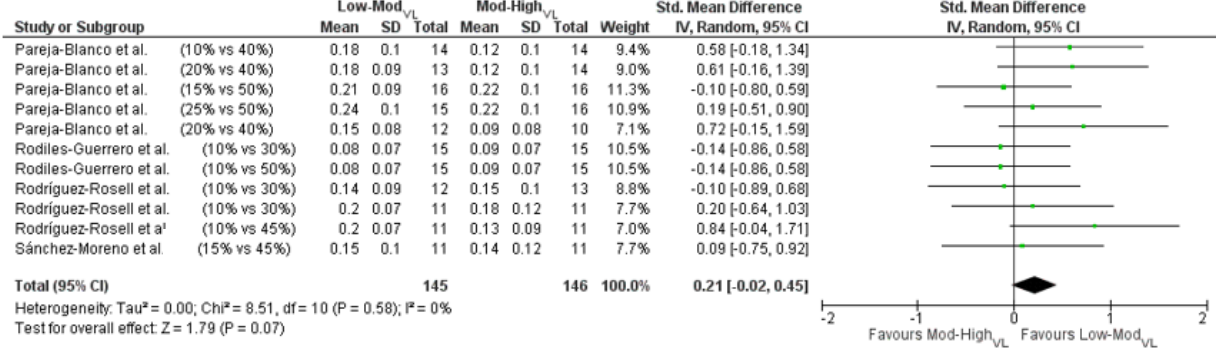
Figure 3. Between-group analysis comparing the effects of Low-Mod VL (≤25% intra-set VL) and Mod-High VL (>25% intra-set VL) to promote changes at moderate/high loads (absolute loads lifted slower than 1.00 m·s −1 and 0.80 m·s −1 at pre-training in the squat and bench press exercises, respectively, >60% 1RM [35,36]). Green squares: ES for each individual comparison; Black diamond: pooled ESs. Sánchez-Moreno et al. [31]; Pareja-Blanco et al. [35,36,38]; Rodiles-Guerrero et al. [39]; Rodríguez-Rosell et al. [34,40].